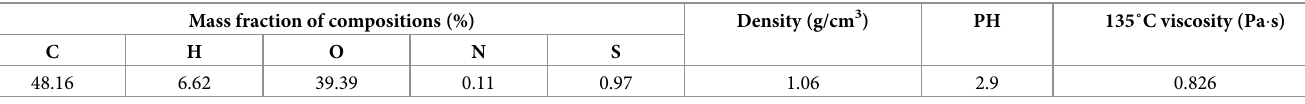
Table 4. Technical parameters of the bio-oil. Mass fraction of compositions